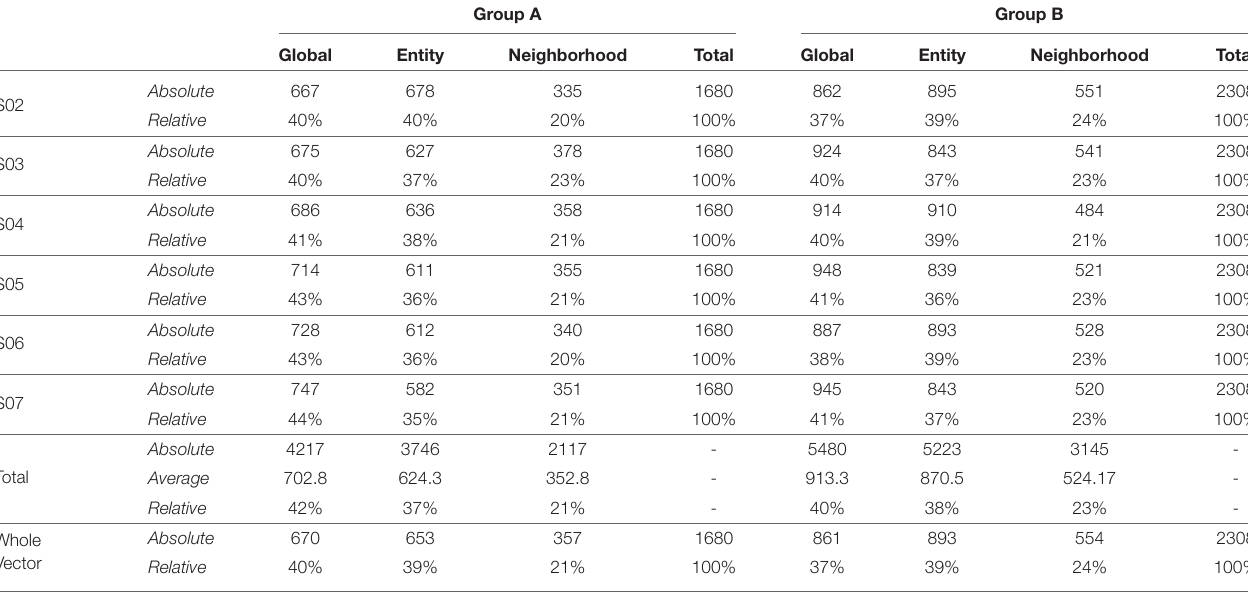
TABLE 5 | Number of invocations for the global and local models by ensemble predictors and whole vector predictor using optimal sampler as a sampling strategy. Group